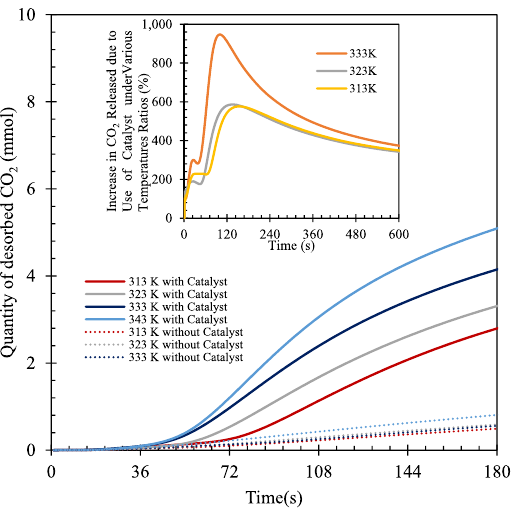
Figure 4. Effect of temperature on catalytic NaHCO 3 decomposition or CO 2 desorption [initial NaHCO 3 concentration: 0.143 mol/L; Ti/Na molar ratio: 0.78; stirring rate: 600 rpm; N 2 flow rate: 500